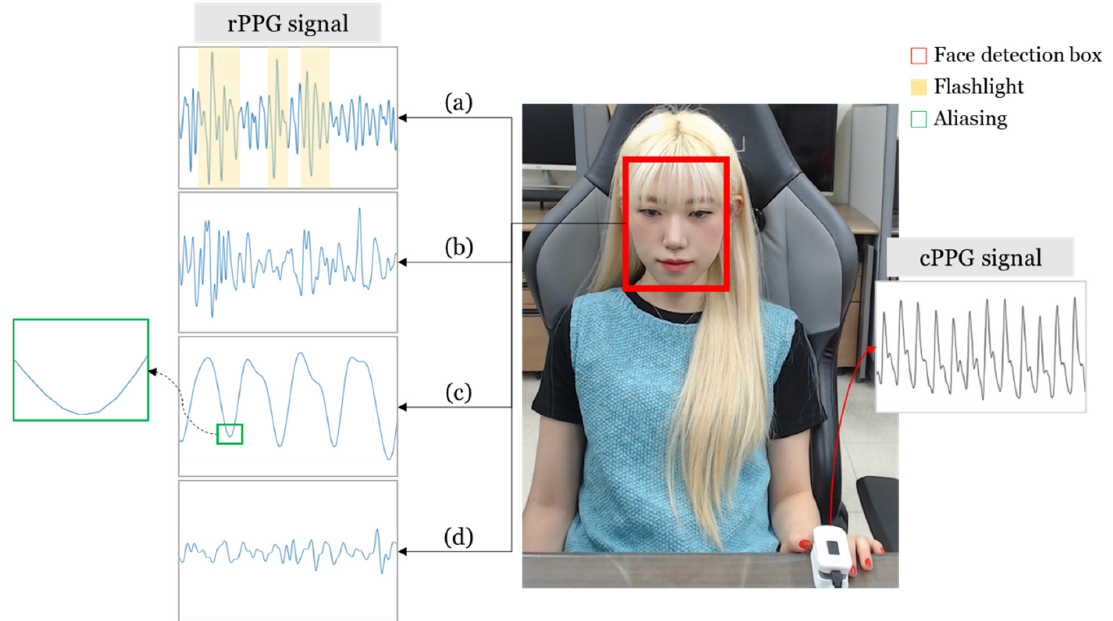
Figure 2. rPPG signal degradation model: ( a ) Abrupt changes in amplitude by illumination factor; ( b ) motion artifacts caused by facial movements; ( c ) aliasing due to lower sampling rate compared to cPPG; ( d ) poor signal quality due to the low sensitivity of the image sensor.